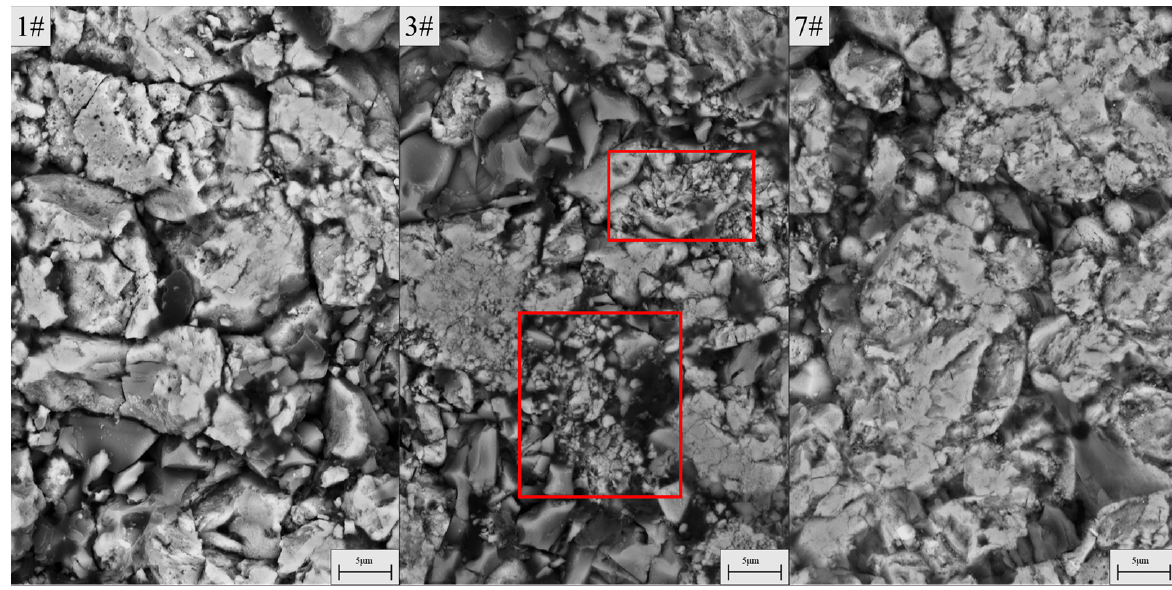
Figure 9. SEM images of the first reduction stage of iron oxides with different basicities.